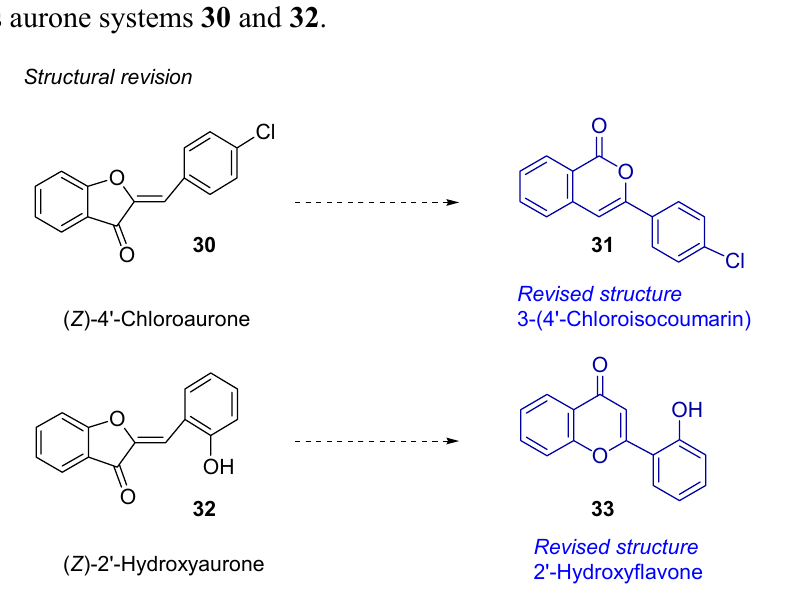
Figure 4. New assignation of structures 31 and 33 by comparison with the prepared by the gold catalysis aurone systems 30 and 32